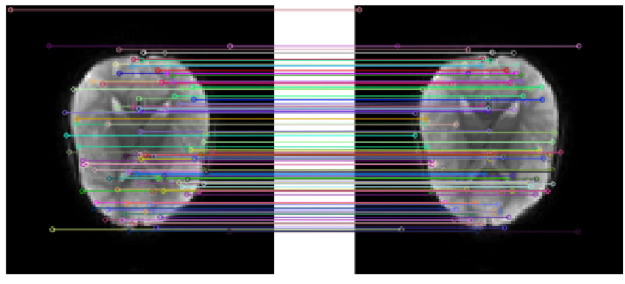
Figure 5. Example of feature point matching of t 0 image and t 1